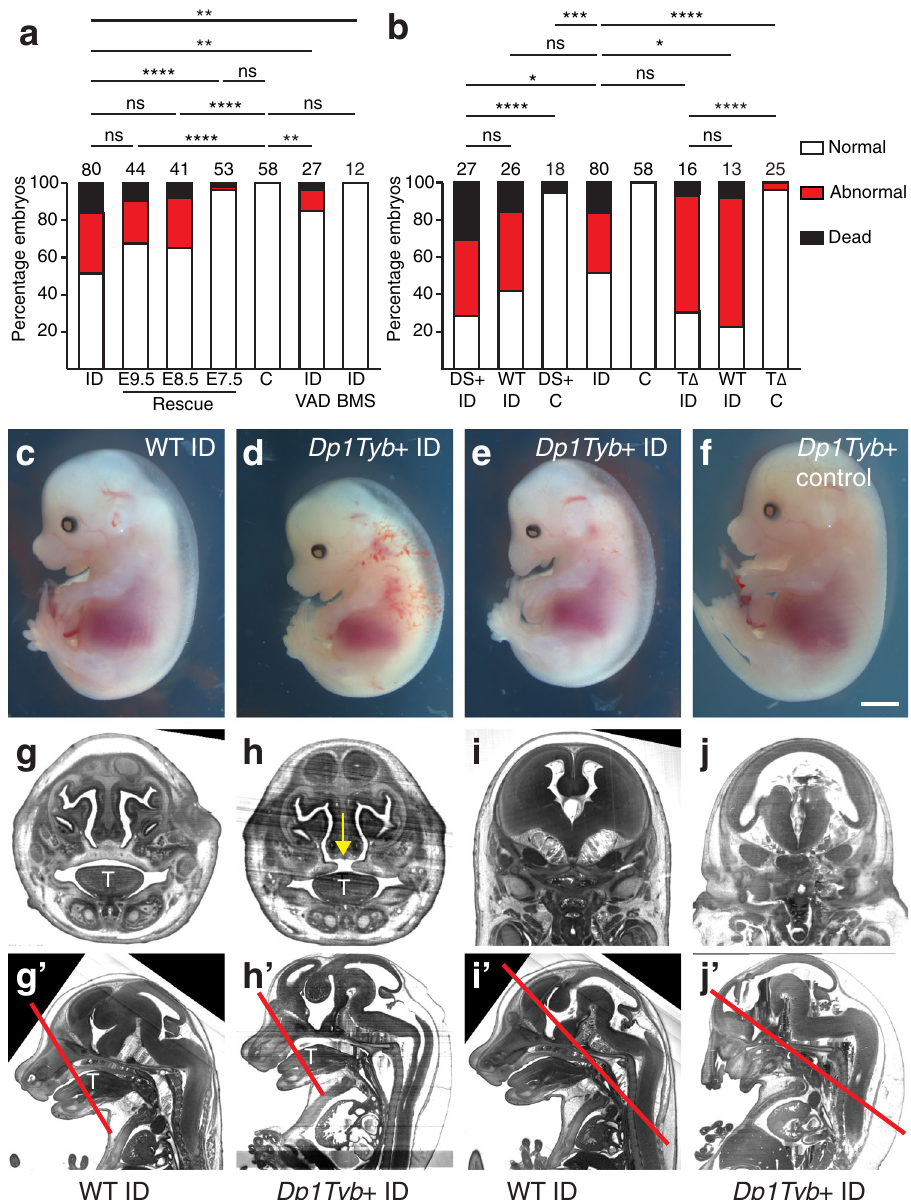
Fig. 6 Phenotypic rescue and gene-environment interaction. a Phenotypic rescue. Pregnant mice were returned to iron-replete diet between E7.5-E9.5; fed continuously on an iron and vitamin A de fi cient diet (ID/VAD); or fed continuously on an iron de fi cient diet and treated with 0.7 mg/ml BMS493 on E8.5 and E9.5 (ID/BMS). Histograms showing the percentage of embryos that were dead, abnormal or normal at E15.5. b Investigation of gene – environment interaction. Iron de fi cient (ID) and control (C) C57BL/6 J females were crossed with males carrying the Tbx1 null allele (T Δ ), or the Dp1Tyb duplication (DS + ). Histograms showing the percentage of embryos that were dead, abnormal or normal at E15.5. c – f Representative images of Dp1Tyb + control ( c ), wild type control ID ( d ), Dp1Tyb + ID with holoprosencephaly ( e ), Dp1Tyb + control ( f ), E15.5 embryos. g – j Dp1Tyb + embryos from ID mothers have craniofacial defects. Representative 3D reconstructed frontal sections of HREM data from wild type ID ( g , i ) and Dp1Tyb + ID ( h , j ) E15.5 embryos showing examples of failed secondary palate fusion ( h , yellow arrow) and holoprosencephaly ( j ). g ’ – j ’ Sagittal sections from the same embryos showing the location of the sections in ( g – j ) (red lines). note that panels ( g ) and ( i ) are the same control embryo. T tongue. Statistical signi fi cance was tested using one-sided Fisher ’ s exact test (panel c ). P values: 0.0657 (ID vs E9.5); 0.1127 (ID vs E8.5); <0.0001 (ID vs E7.5); 0.0019 (ID vs ID VAD); 0.0009 (ID vs ID BMS); < 0.0001 (C vs E9.5); <0.0001 (C vs E8.5); 0.2257 (C vs E7.5); 0.0087 (C vs ID VAD); >0.9999 (C vs ID BMS); 0.4859 (DS + ID vs WT ID); <0.0001 (DS + ID vs DS + C); 0.0321 (DS + ID vs ID); 0.2494 (WT ID vs ID); (0.0006 DS + C vs ID); 0.4742 (T Δ ID vs WT ID); <0.0001 (T Δ ID vs T Δ C); 0.1000 (T Δ ID vs ID); 0.0457 (WT ID vs ID); <0.0001 (T Δ C vs ID). ns not signi fi cant, * P < 0.05, ** P < 0.01, *** P < 0.001, **** P < 0.0001. Scale bar = 2 mm ( c – f ); 700 µ m ( g , h ); 1.2 mm ( I , j ); 1.6 mm ( g ’ – I ’ (Fig. 6d; 10/11 Dp1Tyb + ID oedemic embryos with blood- fi lled palate fusion (1/39 wild type ID controls, P < 0.0001, Fig. 6h), and lymphatics compared to 4/11 wild type ID, P = 0.0119). In a further 2 embryos had holoprosencephaly (Fig. 6e, j). By addition, we observed craniofacial defects in surviving Dp1Tyb + contrast, only 1/18 Dp1Tyb + control embryos was dead at E15.5, ID embryos. 10/19 of these embryos had a failure of secondary and none of the survivors had oedema, holoprosencephaly or a